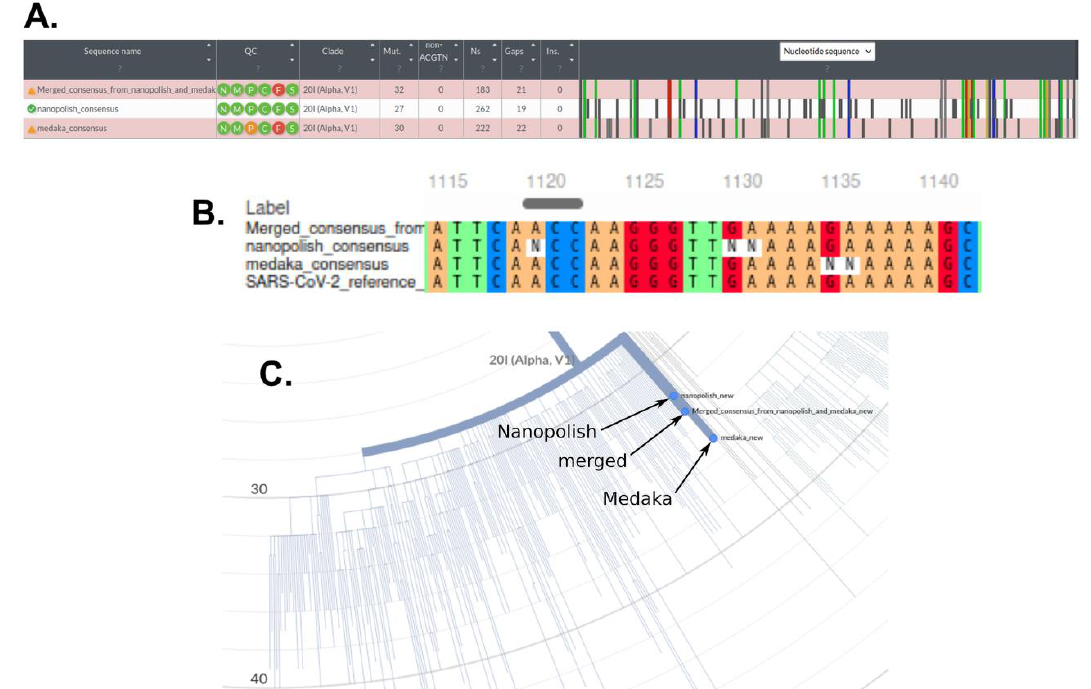
Figure 3. Comparison of the consensus sequences returned by ‘Nanopolish’ and ‘Medaka’ algorithm and the merged consensus for a nanopore sequencing run corresponding to a viral load of 1.28 × 10 6 . ( A ) Alignment of the ‘Nanopolish’ and ‘Medaka’ consensus as well as the merged consensus on the SARS-CoV-2 reference genome by the Nextstrain program. The merged consensus conserved all of the high-quality mutations that mapped to the known variant 20I (shown in color or light grey), while most non-matching mutations (in dark grey, likely sequencing errors) of the ‘Nanopolish’ or ‘Medaka’ consensus were lost; ( B ) Comparison of variant solving by ‘Nanopolish’, ‘Medaka’ and our code. The multiple alignments were performed by MAFFT online tool with the three consensus sequences and the SARS-CoV-2 reference genome (MN908947.3). Contrary to the ‘Nanopolish’ and ‘Medaka’ consensus, the merged consensus solved the entire region and led to accurate variant calling; ( C ) Clade mapping and phylogenetic distances calculated by Nextstrain for the three consensus sequences.